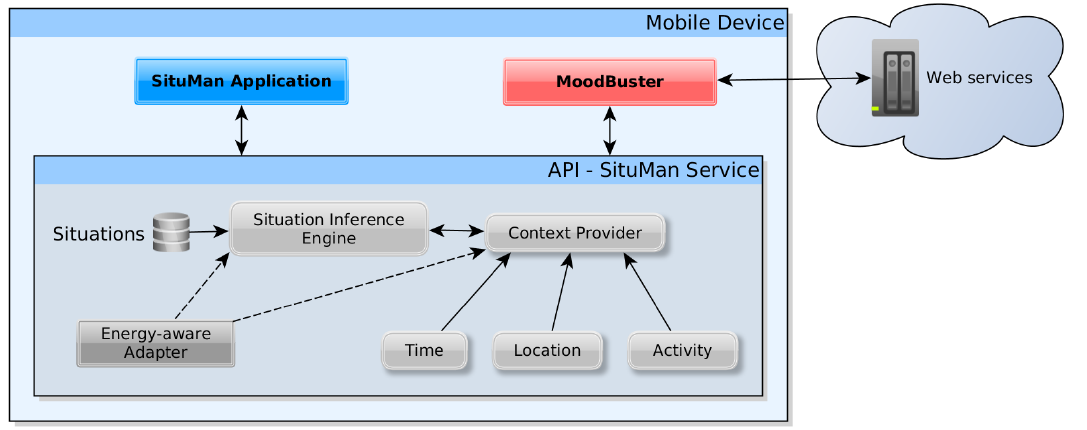
Figure 5. SituMan computational